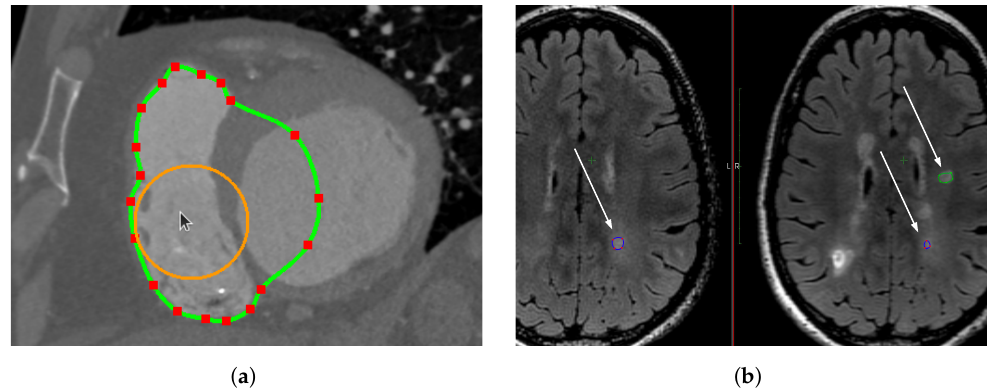
Figure 6. Polygon ROI features. ( a ) Repulsor: the orange circle handled by the user allows to push the boundary of a previously segmented region of interest ( b ) Multiple views: a segmentation is done simultaneously in two views. The arrows show an ingoing segmentation of lesions in blue and green in two reformatted brain images, where the user can easily follow the